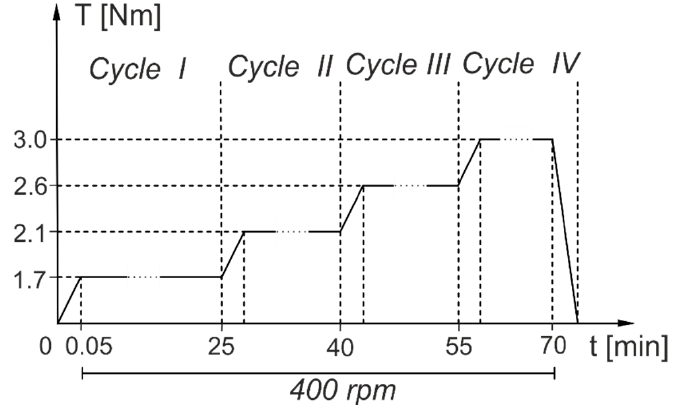
Figure 6. A chart presenting a complete load cycle applied at the test rig.